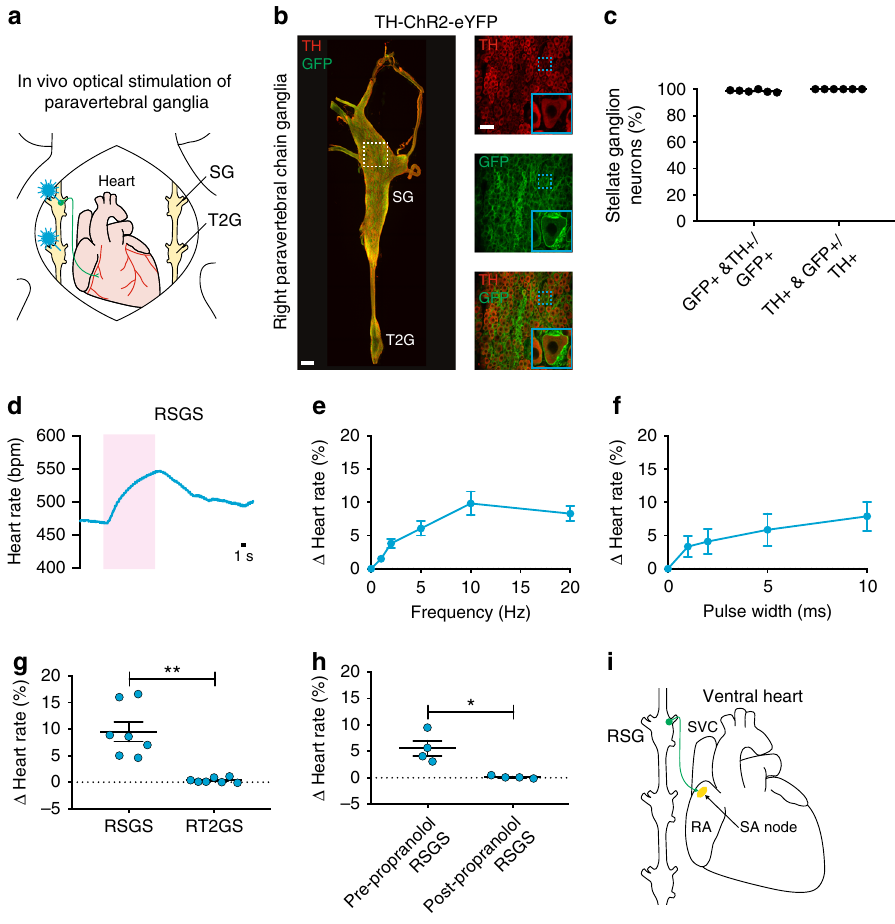
Fig. 6 In vivo optogenetic stimulation of noradrenergic neurons in the RSG. a Cartoon depicting optogenetic SG and T2G stimulation strategy in TH-ChR2- eYFP mice. The right paravertebral chain was surgically exposed in anesthetized mice and light was used for stimulation. b A MIP image of the right paravertebral chain whole-mounted stained with TH (red) and GFP (green) and showing the SG and the T2G. Inset shows single-plane images of the SG. Blue dashed boxes indicate location of higher magni fi cation images in blue boxes. c Percentage of stellate ganglion neurons expressing GFP and TH over those expressing GFP or TH. d Representative heart rate response during 10 Hz, 10 ms, and 126 mW craniomedial RSG stimulation (RSGS). e , f Dose response curves summarizing the effects of altering craniomedial RSGS frequency ( e ) and pulse width ( f ) on heart rate. g Summary of the heart rate response to craniomedial RSGS versus right T2G stimulation (RT2GS) ( t 6 = 5.435, ** P = 0.0016). h Summary of the heart rate response to craniomedial RSGS before versus after propranolol administration ( t 3 = 3.951, * P = 0.0289). i Cartoon of the ventral heart depicting the craniomedial RSG-SA node circuit . n = 6 mice ( c ), seven mice ( e , g ), fi ve mice ( f ), and four mice ( h ); mean ± s.e.m.; paired, two-tailed t -test. Scale bars are 200 µ m ( b (left) and 50 µ m ( b